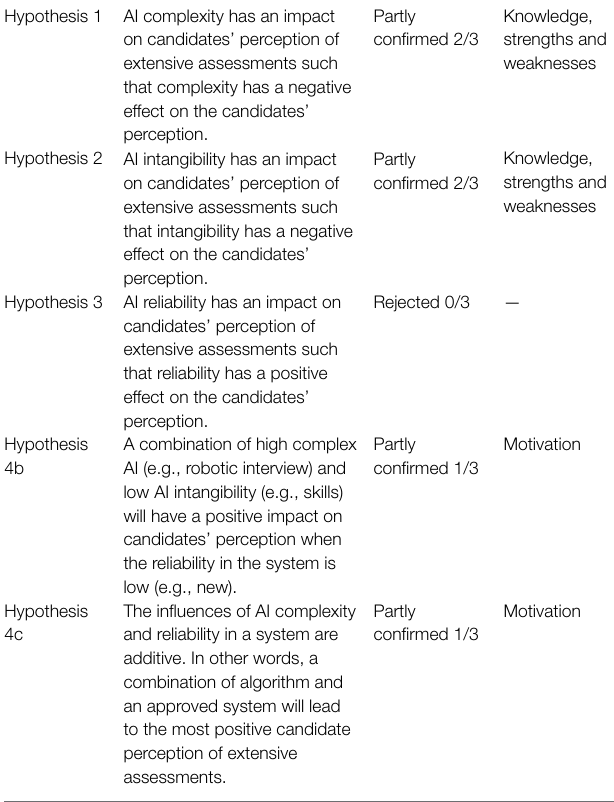
TABLE 3 | Overview of hypothesis